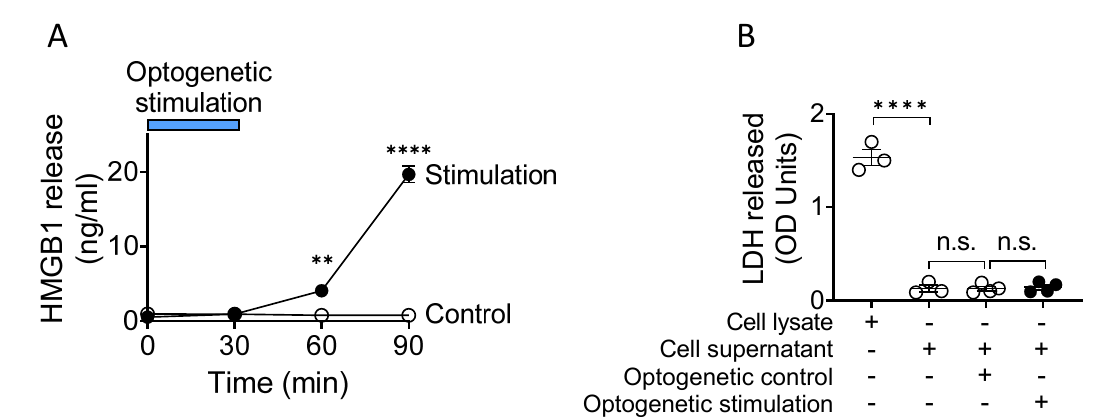
Figure 2. Stimulated neurons actively release HMGB1. ( A ). Sensory neurons harvested from dorsal root ganglia (DRG) of Vglut2-Cre/ChR2-eYFP mice were cultured and exposed to (470 nm; stimulates) or yellow light (595 nm, not-stimulating control) at 20 Hz, and 10% duty cycle for 30 min using optical fiber-coupled LEDs. Blue bar indicates the duration of stimulation. A time-dependent increase in secreted HMGB1 levels is observed following optogenetic stimulation (at 60 min: **: p < 0.01, at 90 min: ****: p < 0.0001); reproduced from Yang et al. [27]. ( B ). DRG viability was assessed by release of the soluble cytoplasmic enzyme lactate dehydrogenase (LDH), which leaks out following membrane disruption. Cell lysate was included as positive control. No significant increase in cell death is observed following optogenetic stimulation. n = 3–4 separate experiments, and each performed in duplicate (****: p < 0.0001), n.s.: not significant; reproduced from Yang et al. [27] .